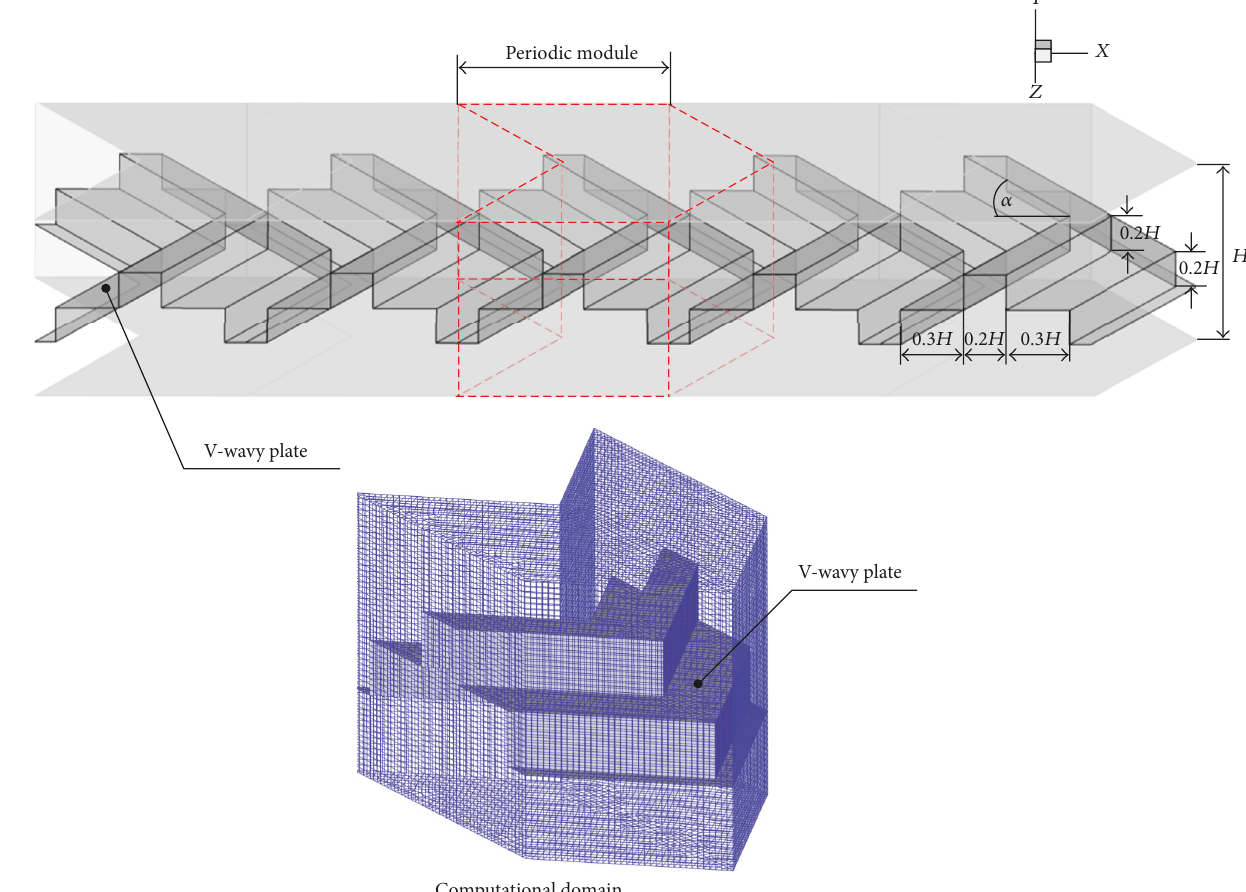
Figure 1: Square channel heat exchanger inserted with V-wavy plate and computational